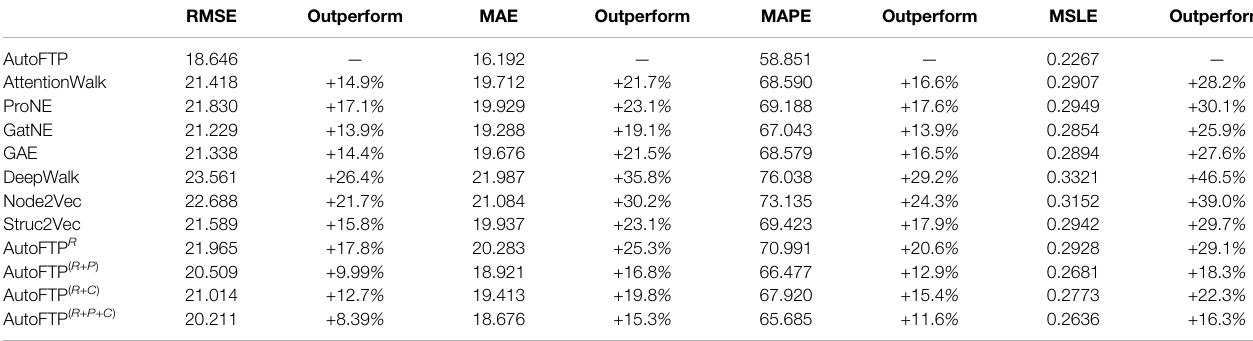
TABLE 2 | Overall Performance with respect to RMSE, MAE, MAPE and MSLE. (The smaller value is, the better performance is). RMSE Outperform MAE Outperform MAPE Outperform MSLE Outperform AutoFTP 18.646